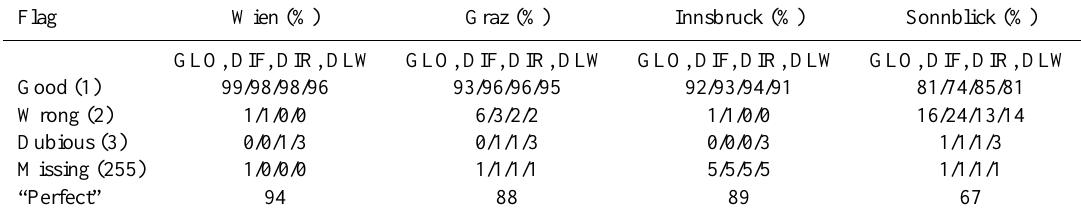
Table 3. Summary of the quality flag statistics (average of 2012–2014) for the measured parameters GLO, DIF, DIR, DLW at four ARAD sites which have been operating since 2012 using the combined daily automated and manual QC including e.g., maintenance times. The last row (“Perfect”) indicates the percentage of timestamps when all four parameters are simultaneously flagged as “good”. Flag Wien